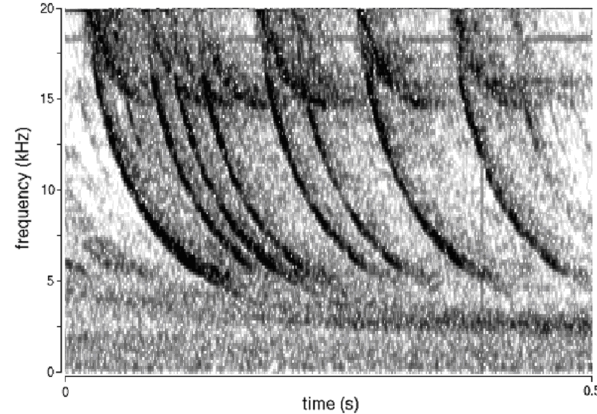
Fig. 5. Anomalistic SpW series, exhibiting single mode pattern with asymptotes at a higher part of the recorded bandwidth are often ob- servable on the DEMETER VLF burst recordings (orbit: 2623 up, sensor: E12, date: 29 December 2004, 20:35:55.1 UT, satellite po- sition: 36.3N; 18.5E, altitude: 701.4, L: 1.51).